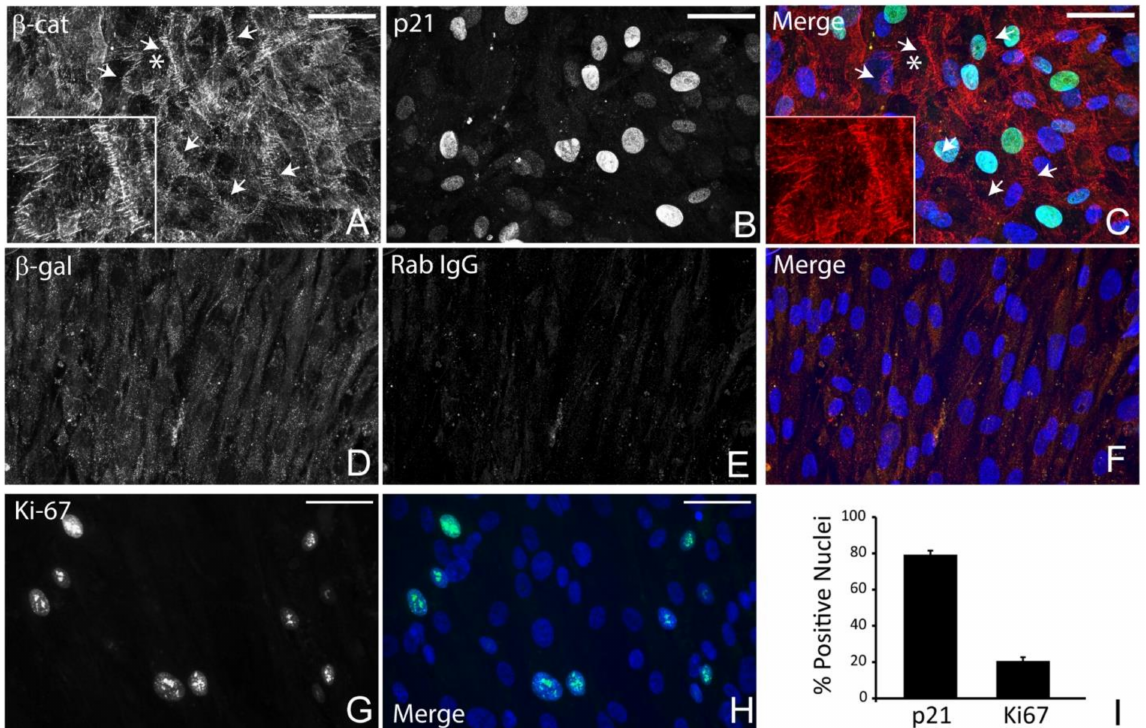
Figure 3. Post confluent HTM cells contain p21-positive nuclei and β -catenin-containing adherens junctions. Seven-day post confluent cultures of HTM cells labeled for β -catenin along sites of cell-cell contact ( β -cat, ( A , C )). Nearly 80% of the cells showed nuclear labeling for p21 ( B , C , I ), while only 20% showed nuclear labeling for Ki-67 ( G – I ). Nuclei are in blue ( C , F , H ). Control antibodies ( D – F ) are described in Methods. Bar = 50 µ m. ( I ). The percentage of nuclei positive for p21 or Ki-67. Asterisk in panels ( A , C ) indicates area enlarged in inset.